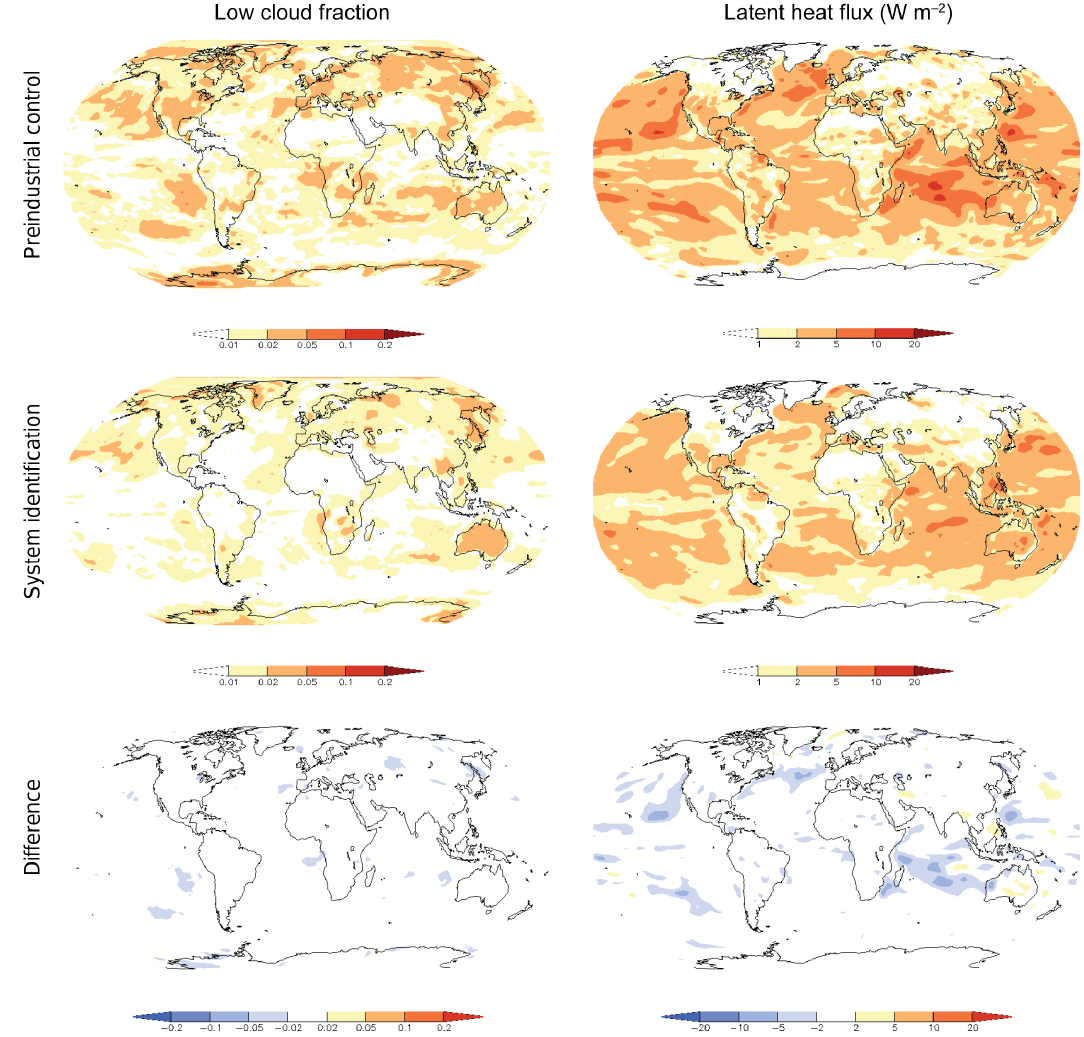
Figure 4. Interannual standard deviation for the simulations considered here. Values are calculated using the annual mean maps as inde- pendent degrees of freedom. The preindustrial control values are calculated using a single 40-year simulation (39 degrees of freedom). The system identification values are calculated using a five-member ensemble of 20-year simulations (95 degrees of freedom). Differences are the middle panels minus the top